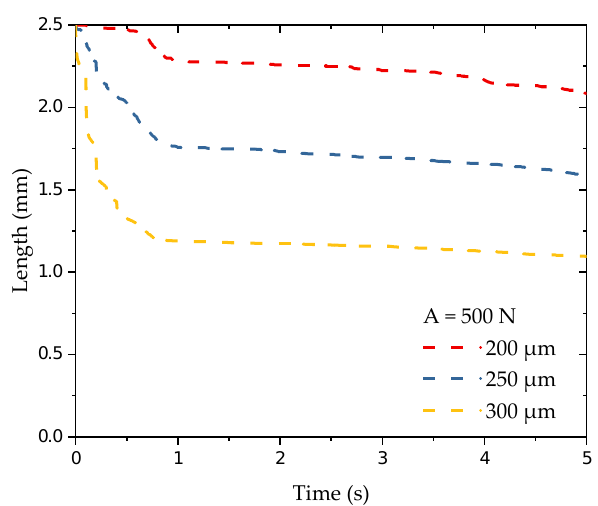
Figure 10. Predicted 𝐿 𝑛 of simple shear flow simulation at varying fiber critical breaking curvature with fiber relaxation applied to the first second in the simulation.